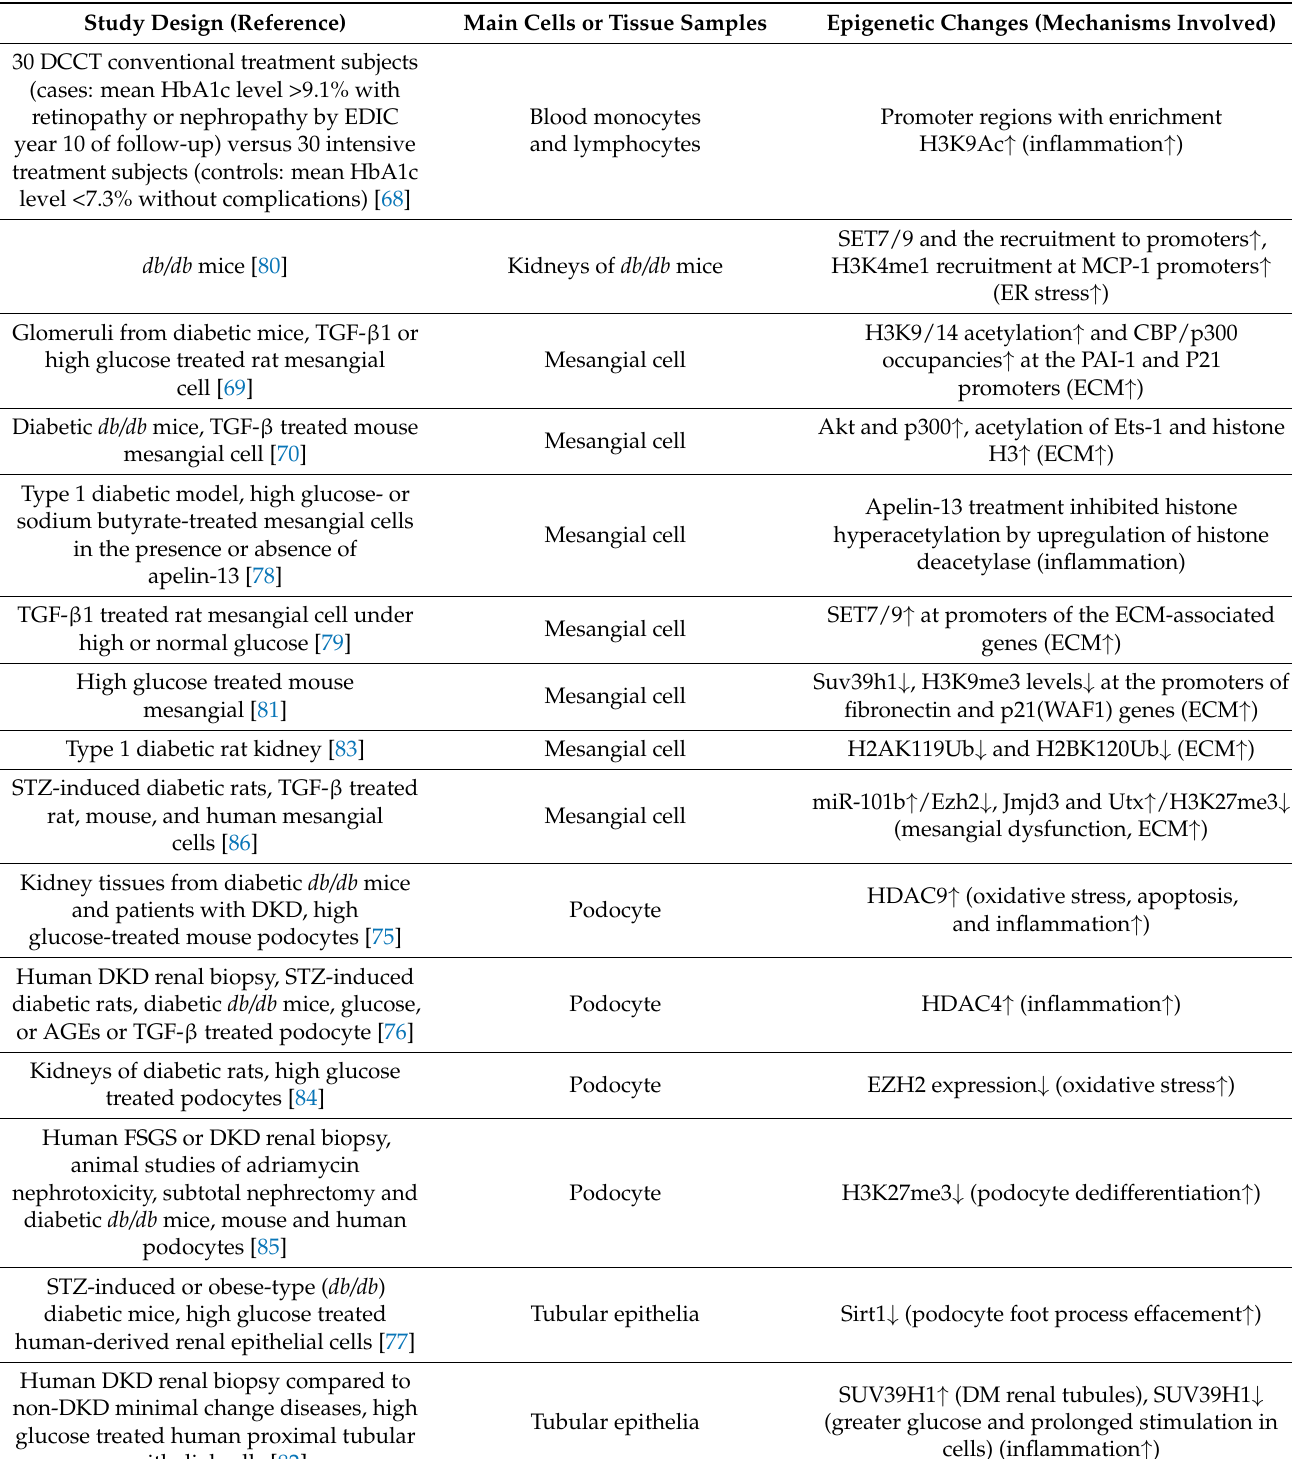
Table 2. Histone modifications in diabetic kidney